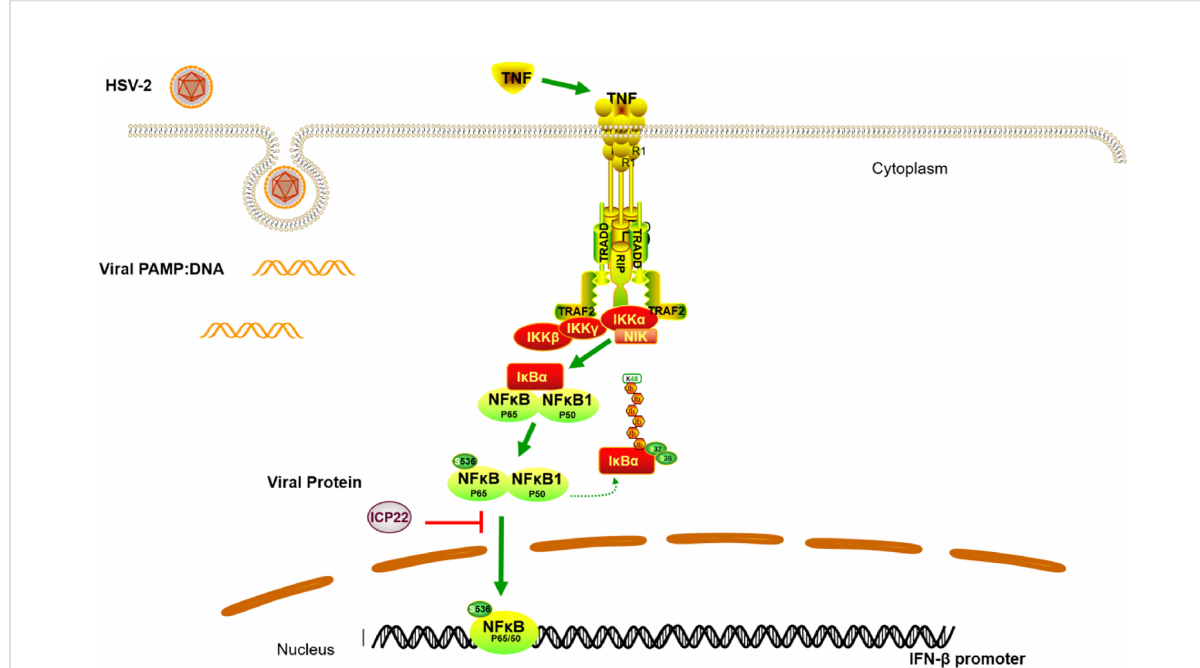
FIGURE 6 A schematic model of the mechanism by which HSV-2 ICP22 blocks TNF- a -induced NF- k B activation. The host recognizes foreign PAMPs and activates the innate immune system to secret cytokines such as TNF- a . TNF- a subsequently binds TNF receptor (TNFR), resulting in the activation of the IKK complex. The inhibitory protein of NF- k B, I k B a , is then phosphorylated, degraded and detached from NF- k B. NF- k B dimers are then released and phosphorylated, and subsequently translocate to the nucleus to activate the expression of immunomodulatory genes. In the case of HSV-2 infection, the viral immediate early protein ICP22 directly interacts with p65 to block p65 phosphorylation and nuclear translocation, leading to an inhibition of NF- k B